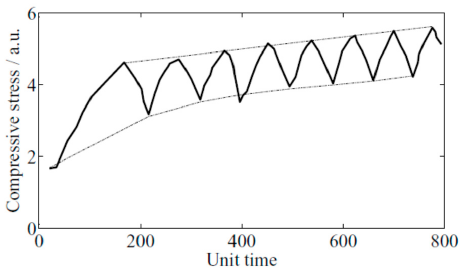
Figure 9. Stress evolution of graphite electrode during galvanostatic cycles at 15 μ A/cm 2 [26].